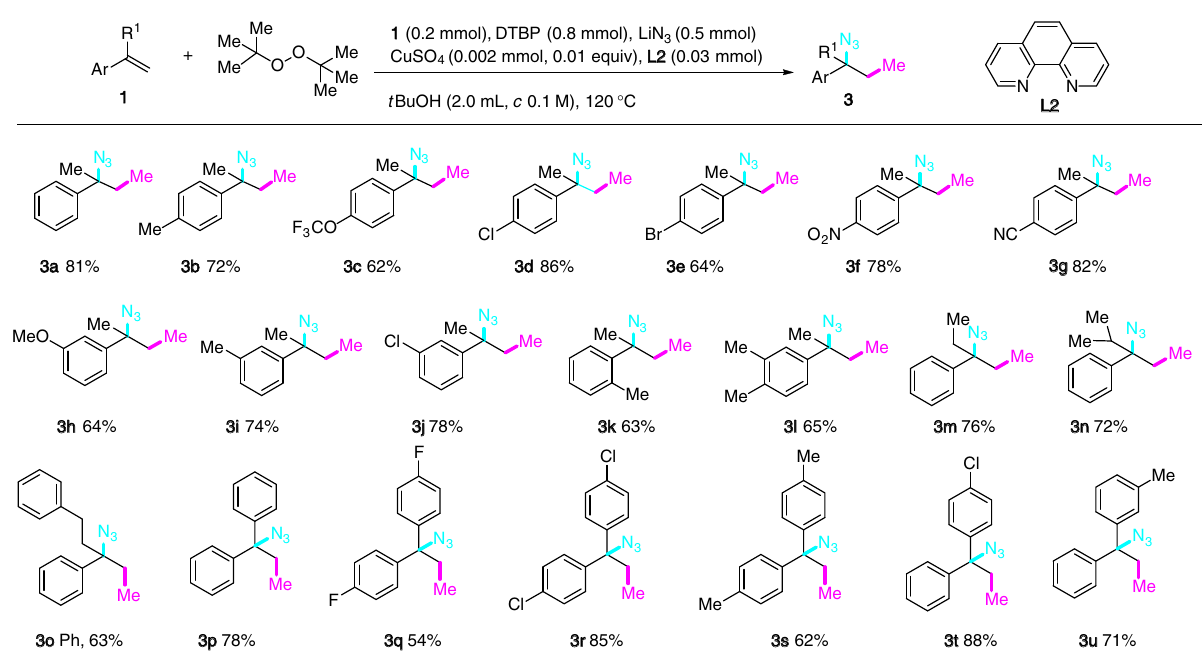
Fig. 3 1,2-Azido methylation of unactivated alkenes. The reaction scheme is shown above the